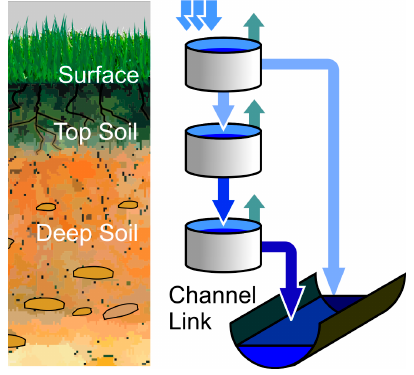
Figure 2. Schematics of the processes represented by the hydrologic model.